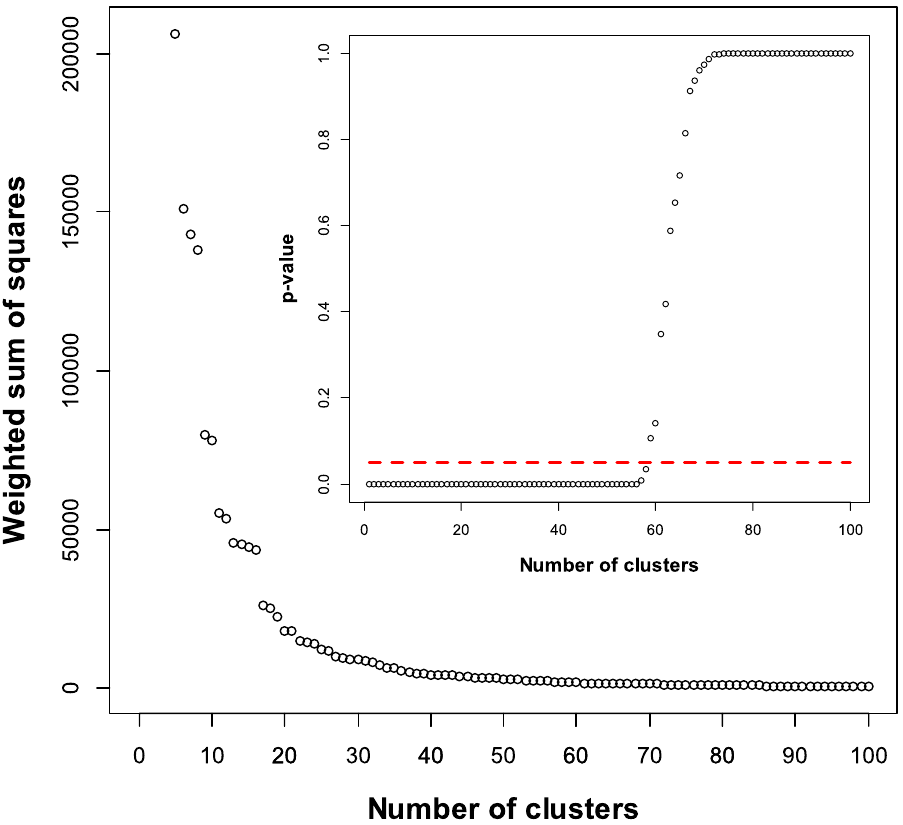
Figure 1. The “elbow” in the weighted sum of squares of differences in the fitted parameters in each cluster (Eq. 1), at 24 clusters, qualitatively indicates how many clusters to keep. With 63 or more clusters there are no ≃ statistically significant differences at the 0.05 level between fitted parameters in each cluster (inset).